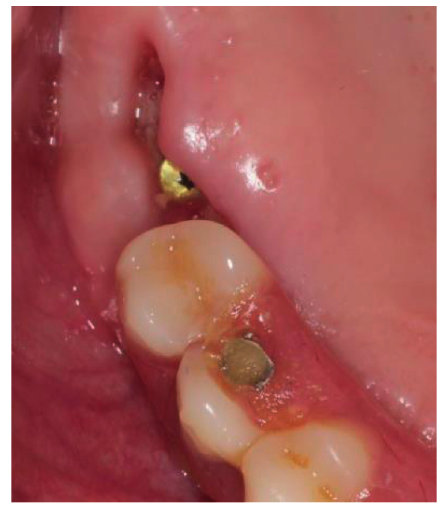
Figure 13: Microbial contamination of soft tissues.